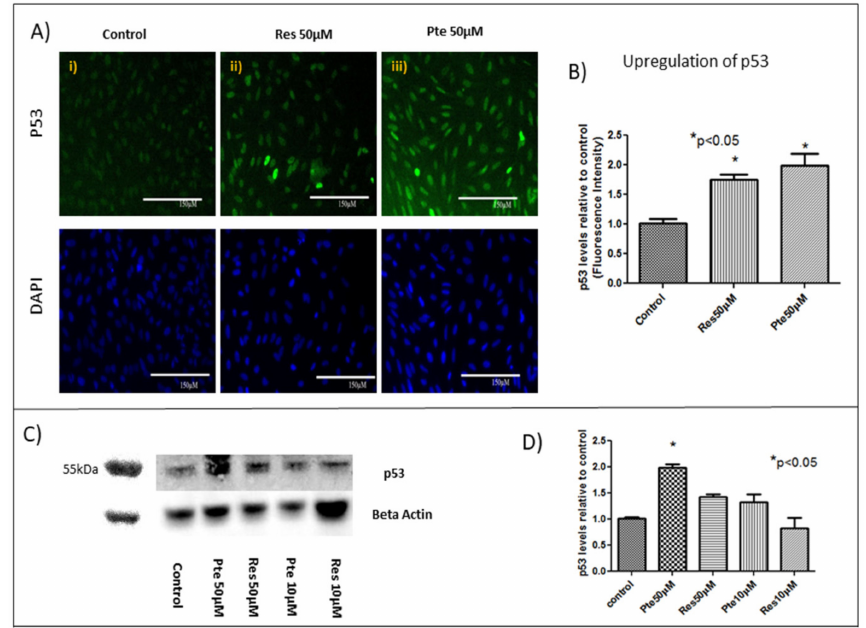
Figure 5. Upregulation of the tumor suppressor protein p53 in HeLa cells treated with resveratrol and pterostilbene: ( A ) Immunoflourescent images of p53 protein (green) untreated or after treatment with 50 µ M of either resveratrol (Res) or pterostilbene (Pte) for 22 h. Levels of p53 are elevated in cells treated with either polyphenol. ( B ) Image analysis of p53 immunofluorescence indicates that pterostilbene treatment at 50 µ M elicited a significant 2-fold increase in p53, while resveratrol exposure at similar concentrations induced a significant 1.75 increase in p53. The graph represents data from experiments obtained from three independent experiments normalized to the control (mean % normalized to DAPI ± S.E.M. * p < 0.05). ( C ) Western blot analysis also revealed that the elevation of p53 protein levels is evident in HeLa cells treated with 50 µ M of resveratrol and pterostilbene; however, significant differences relative to the control were only reached with HeLa cells treated pterostilbene at 50 µ M. ( D ) The graph represents data from experiments obtained from three independent experiments normalized to the control (mean % normalized to beta-actin ± S.E.M.; * p <